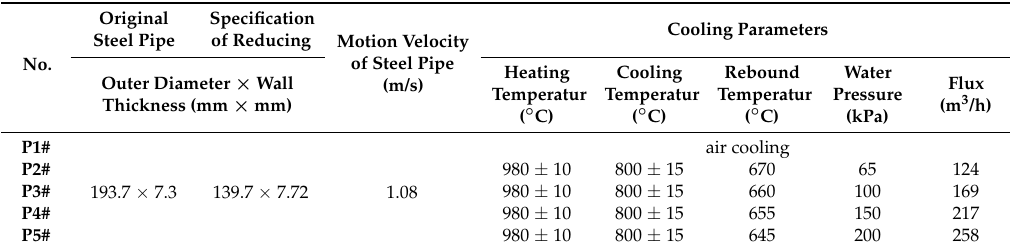
Table 3. OSWC parameters of industrial test for ERW steel pipes.